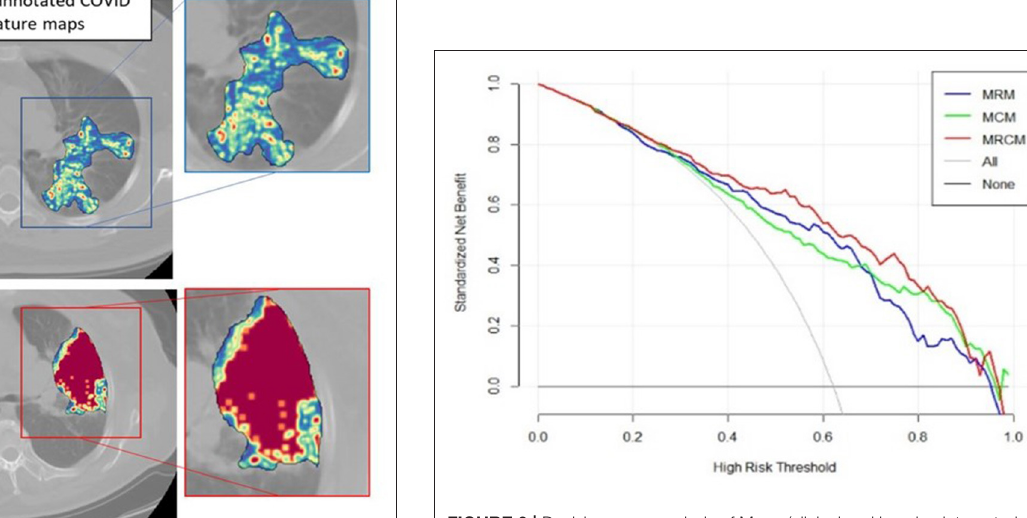
FIGURE 6 | Decision curve analysis of M RCM (clinical and imaging integrated nomogram) constructed using developed radiomic score, age, and three